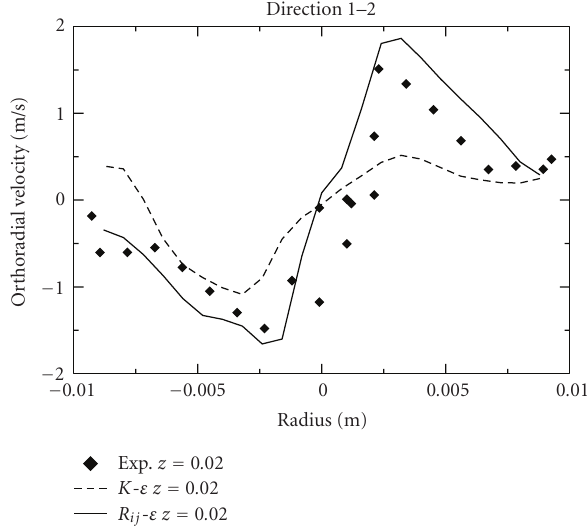
Figure 1: Orthoradial liquid velocity downstream the mixing vane (Agate-mixing experiment).